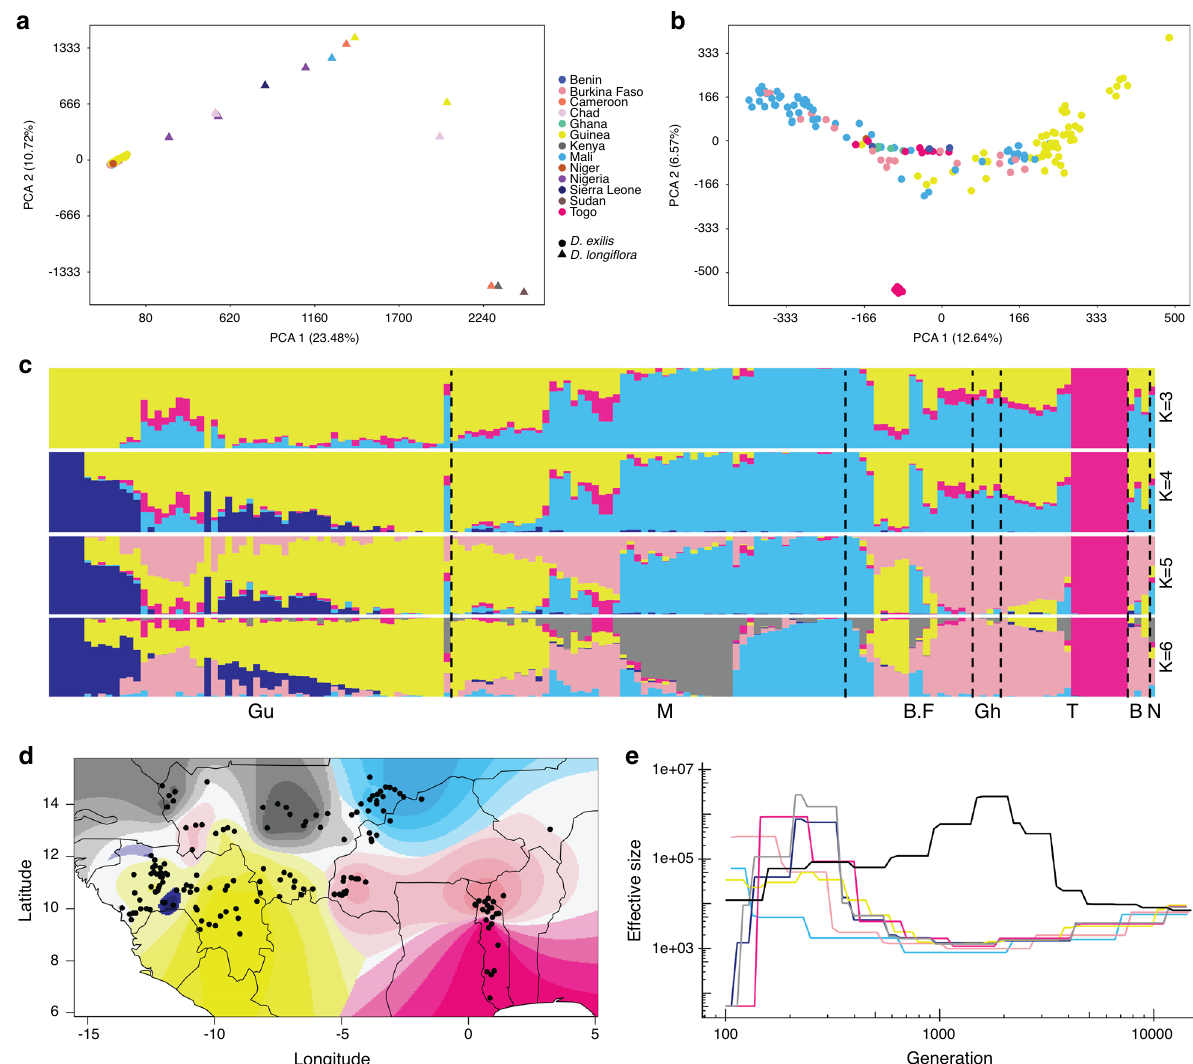
Fig. 3 Genetic diversity and structure of D. exilis and D. longi fl ora diversity panel. a Principal component analysis (PCA) of 157 D. exilis and 14 D. longi fl ora accessions using whole-genome single nucleotide polymorphisms (SNPs). D. exilis samples (circles), D. longi fl ora (triangles). b PCA of D. exilis accessions alone. Colors indicate the country of origin. c Population structure (from K = 3 to K = 6) of D. exilis accessions estimated with sNMF. Each bar represents an accession and the bars are fi lled by colors representing the likelihood of membership to each ancestry. Accessions are ordered from west to east; Guinea (Gu), Mali (M), Burkina Faso (B.F), Ghana (Gh), Togo (T), Benin (B), and Niger (N). d Geographic distribution of ancestry proportions of D. exilis accessions obtained from the structure analysis at K = 6. The colors represent the maximal local contribution of an ancestry. Black dots represent the coordinates of D. exilis accessions. e Effective population size history of D. exilis groups based on K = 6 and D. longi fl ora (in (ethnicity and language) factors had an effect on shaping the genetic population structure of fonio (Fig. 3c, d, Supplementary Fig. 14d). We observed a signi fi cant correlation (Pearson ’ s correlation; p < 0.05, df = 155) between the genetic population structure ( fi rst principal component of PCA) and climate (i.e., mean temperature and precipitation of the wettest quarters) as well as geography (i.e., latitude, longitude, and altitude) (Fig. 3b, Supplementary Fig. 15, Supplementary Data 6). The relationship between genetic differentiation (genetic distance matrix) and climate was still signi fi cant when accounting for geographic distance (partial Mantel test; Mantel r = 0.30; p = 0.001). A signi fi cant correlation was also observed between the genetic distance matrix and the dissimilarity matrices of ethnic and linguistic groups ( fi sher test; p = 0.0005, Mantel test; Mantel r ethnic = − 0.19; Mantel r linguistic = − 0.13; p = 0.001). The effect of ethnic groups remained signi fi cant even when we